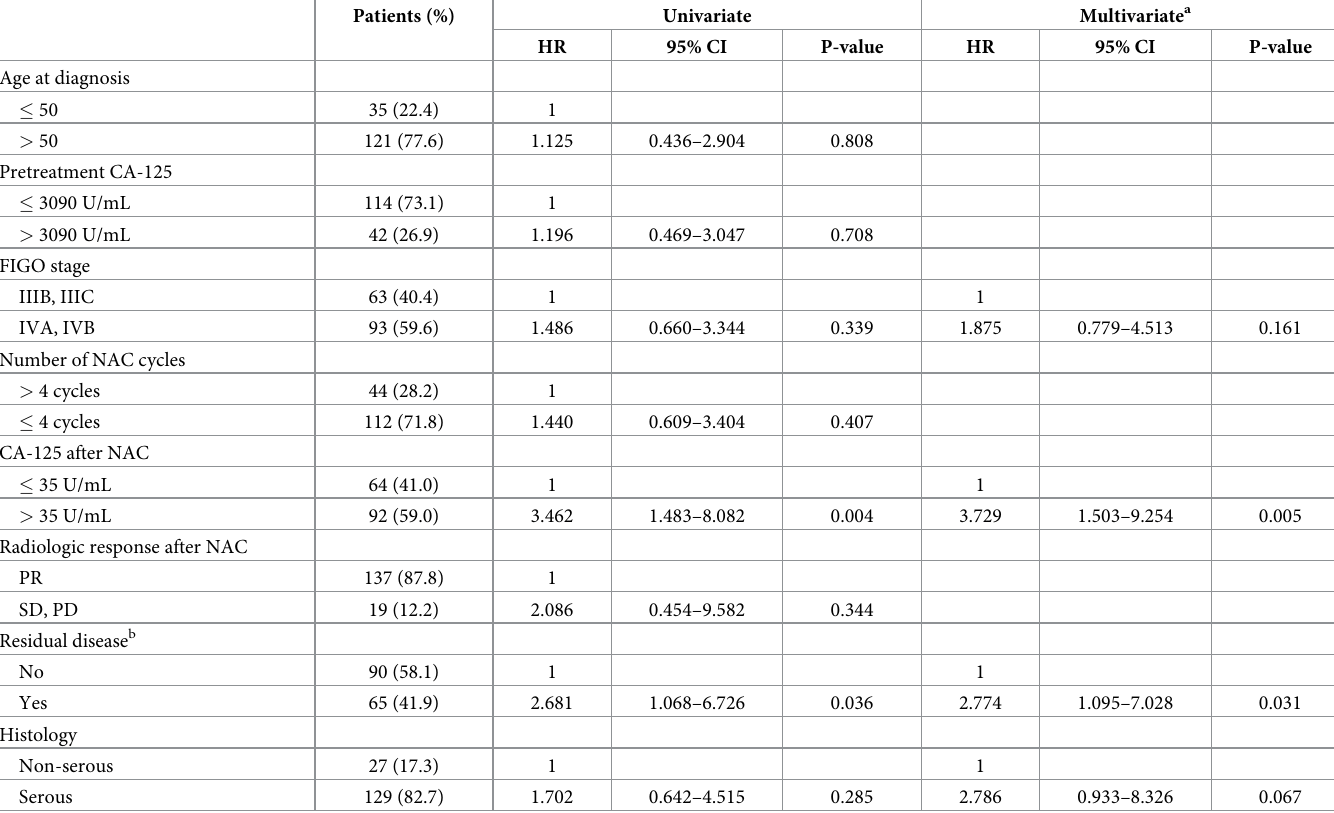
Table 3. Univariate and multivariate logistic regression analysis of factors affecting recurrence of ovarian cancer.